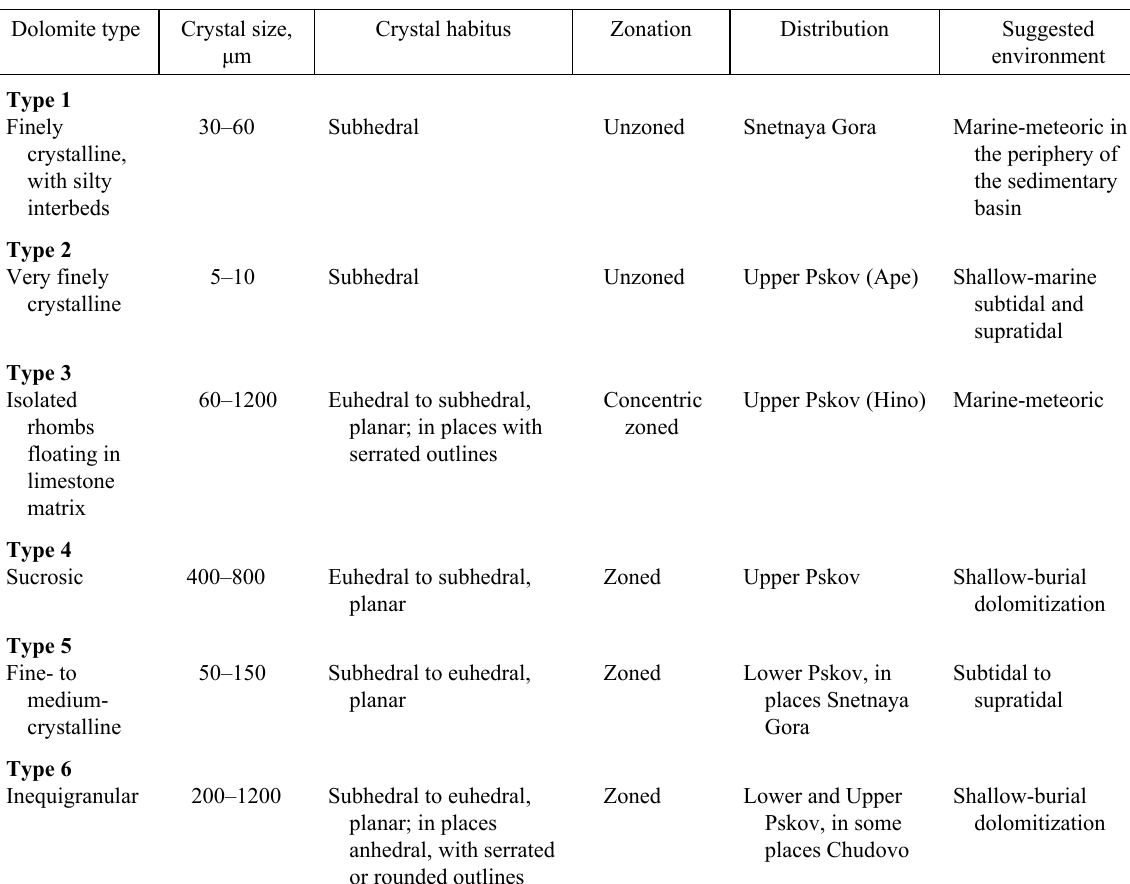
Table 2. Characteristics of dolomite